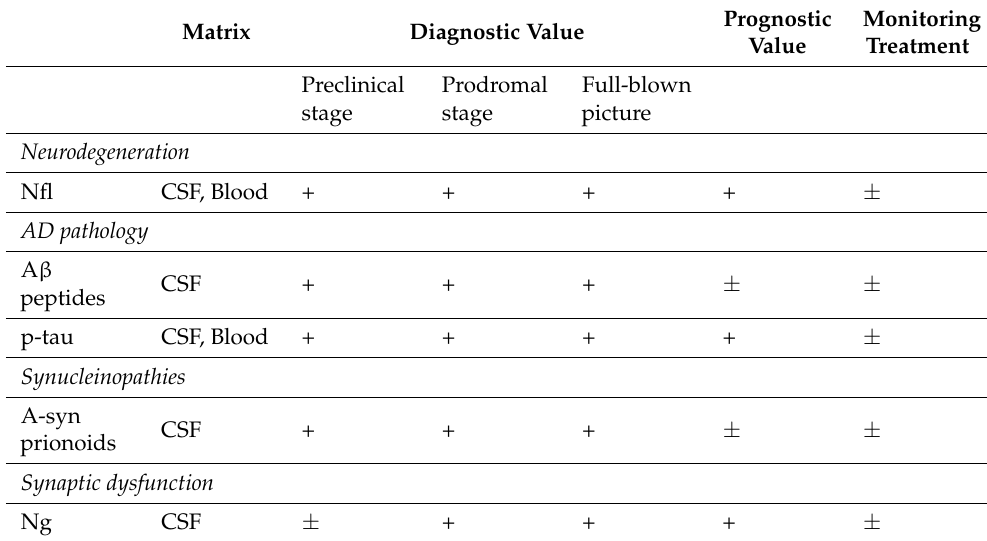
Table 5. Overview of candidate fluid biomarkers for a stratification of neurodegenerative diseases.